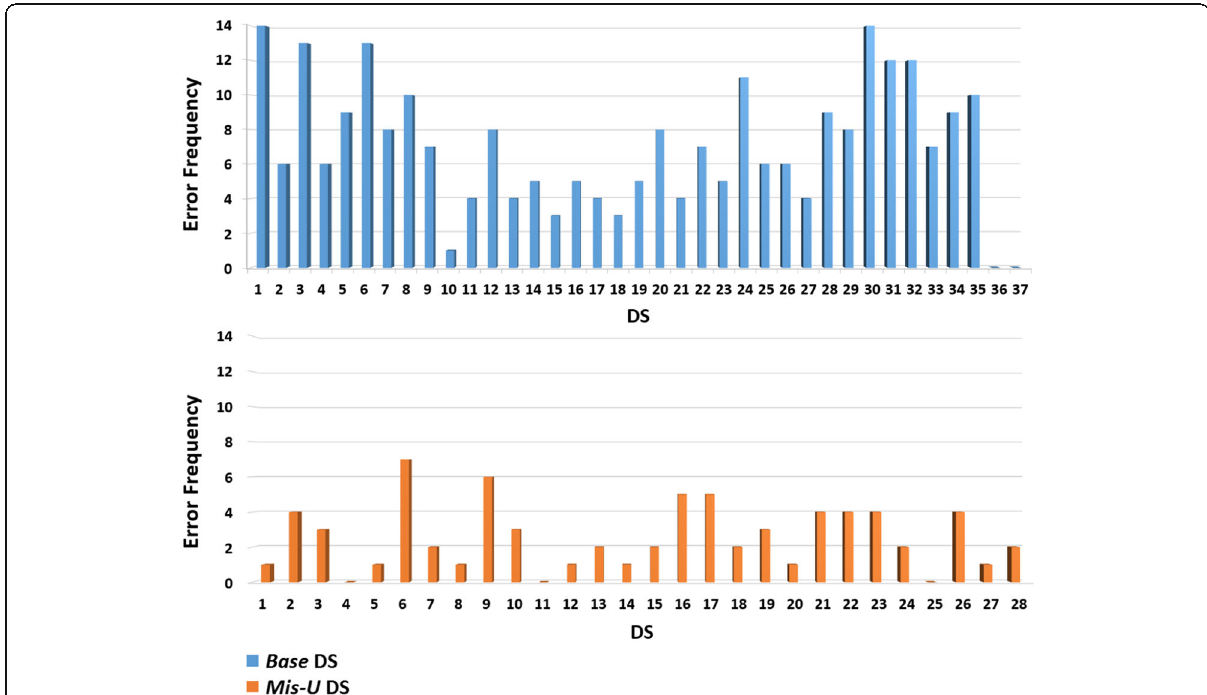
Fig. 12 Error frequency on the detection of Base and Mis-U